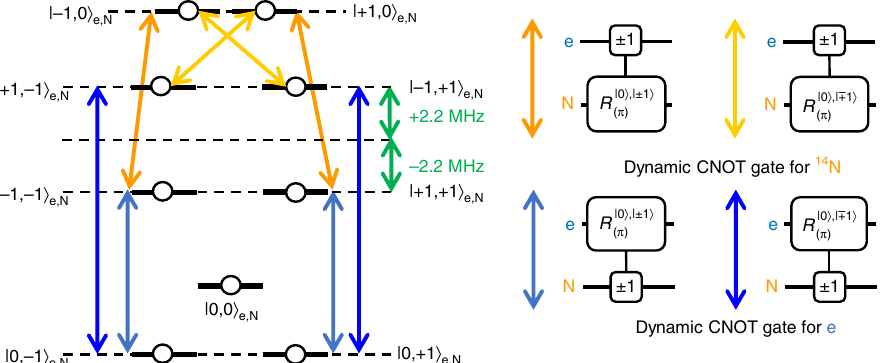
, and the odd-parity states | e ; N